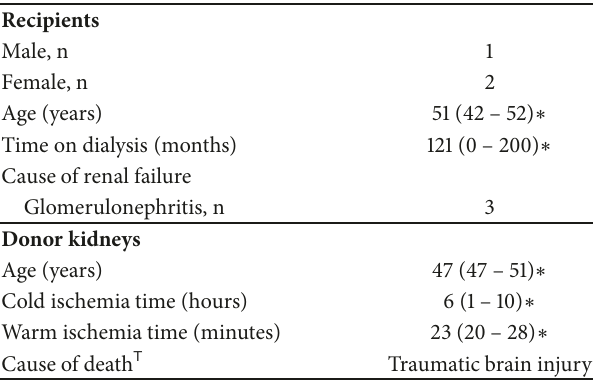
Table 1: Recipient demographics and donor organ characteris- tics . Donor organs comprise two kidneys from the same deceased donor, and one from a living